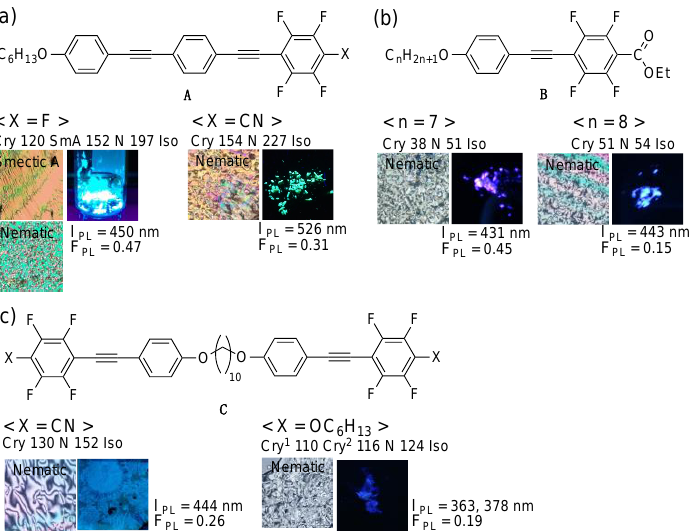
Figure 1. Chemical structure, phase transition behavior, and crystalline-state photoluminescence (PL) behavior of ( a ) fluorinated bistolane-based PL liquid crystals (PLLCs) ( A ), ( b ) fluorinated tolane-based PLLCs ( B ), and ( c ) fluorinated tolane dimer-type PLLCs ( C ).